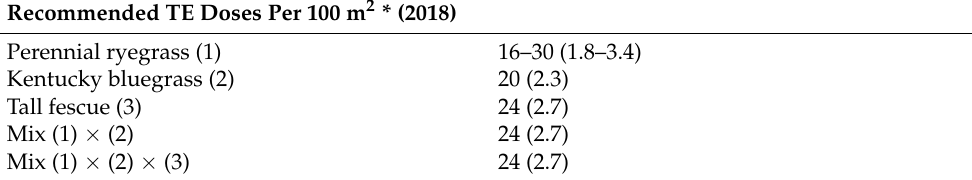
Table 1. Recommended doses [ml and g of active ingredient/100 m 2 ] of trinexapac-ethyl (TE) for application on turfgrass species: perennial ryegrass, Kentucky bluegrass, and tall fescue in different years, as specified on Primo maxx ® (Syngenta) product label information. The trinexapac-ethyl concentration is 12